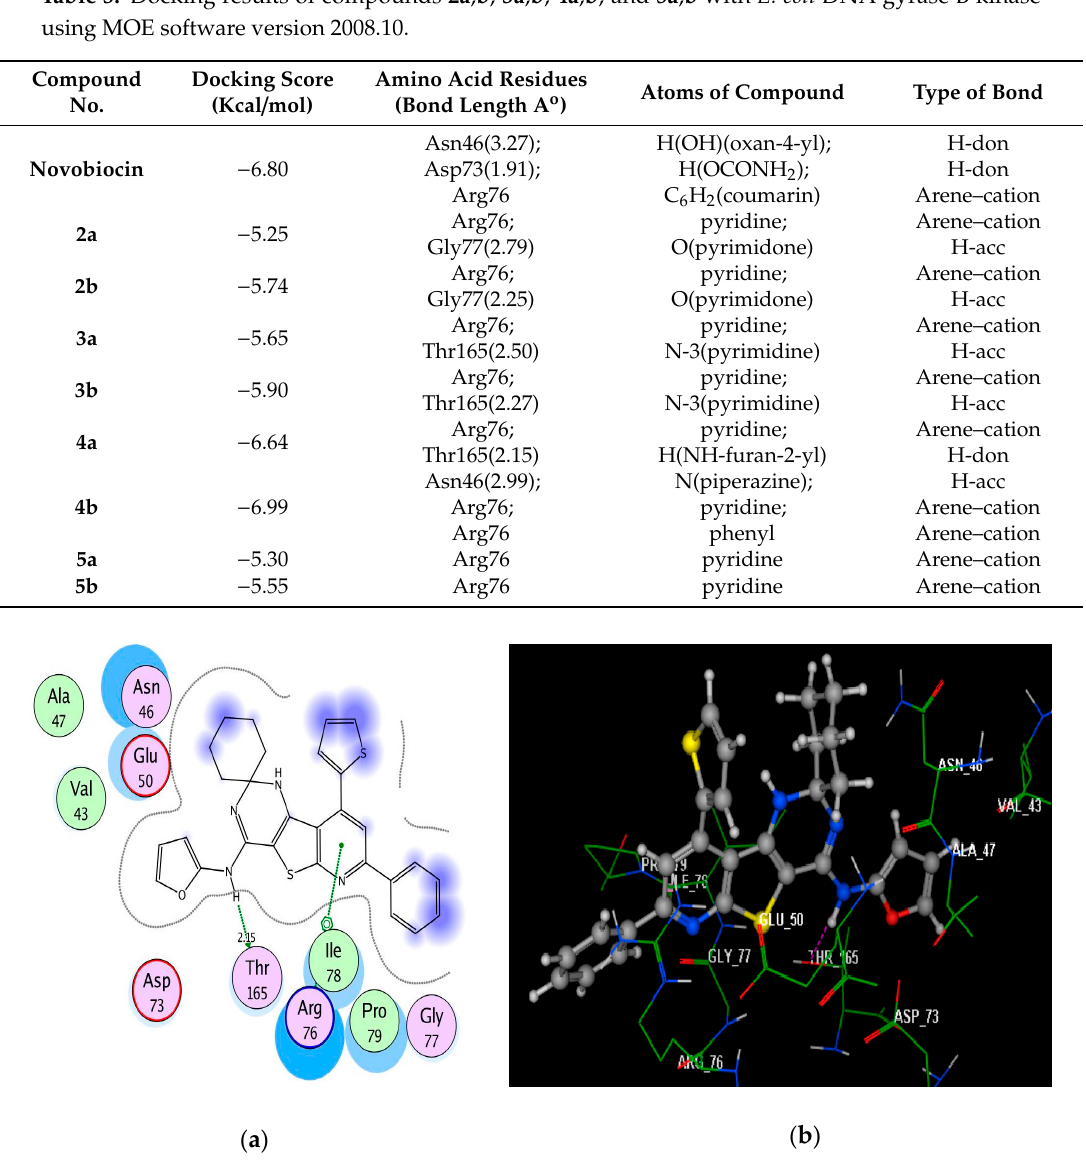
Figure 4. ( a , b ) Diagrams illustrating the 2D and 3D binding patterns of compound 4a onto the ATP-active pocket of E. coli DNA gyrase B kinase (PDB code: 1AJ6),